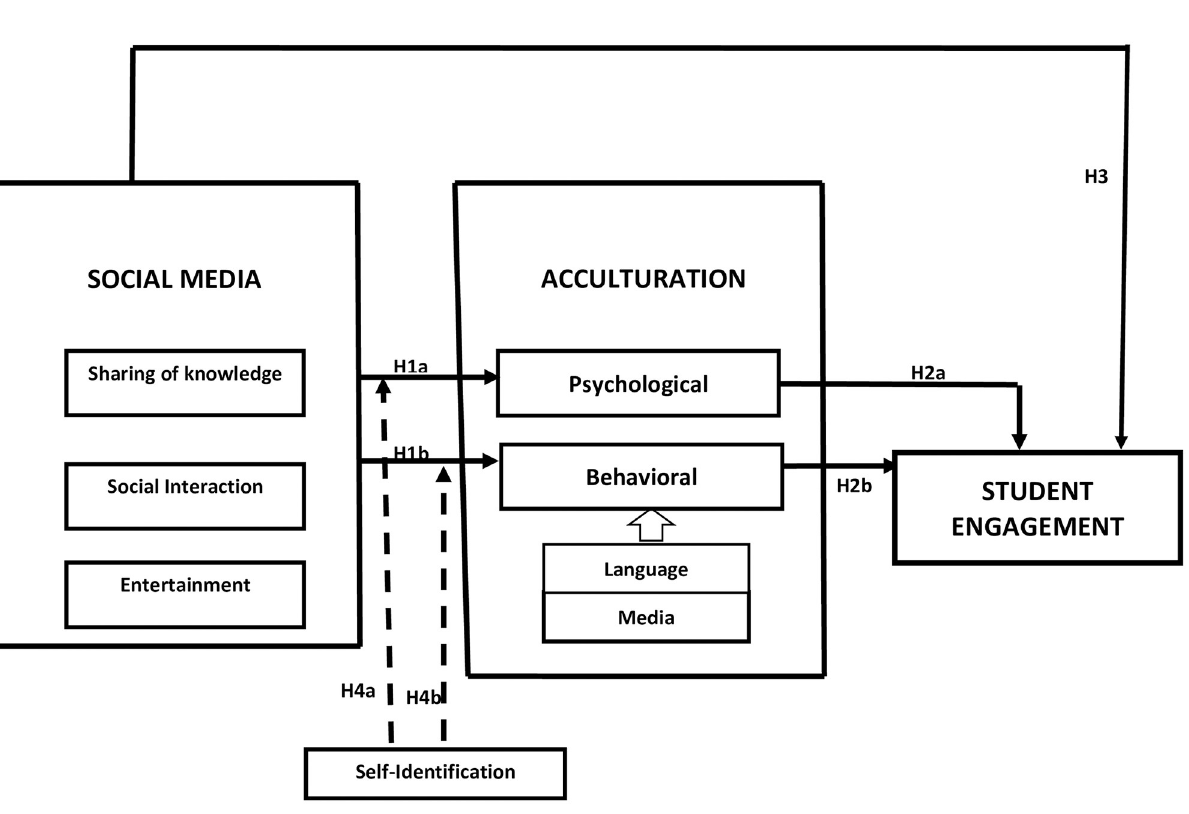
Fig 2. Hypothetical framework showing the relationship between social media, acculturation and student